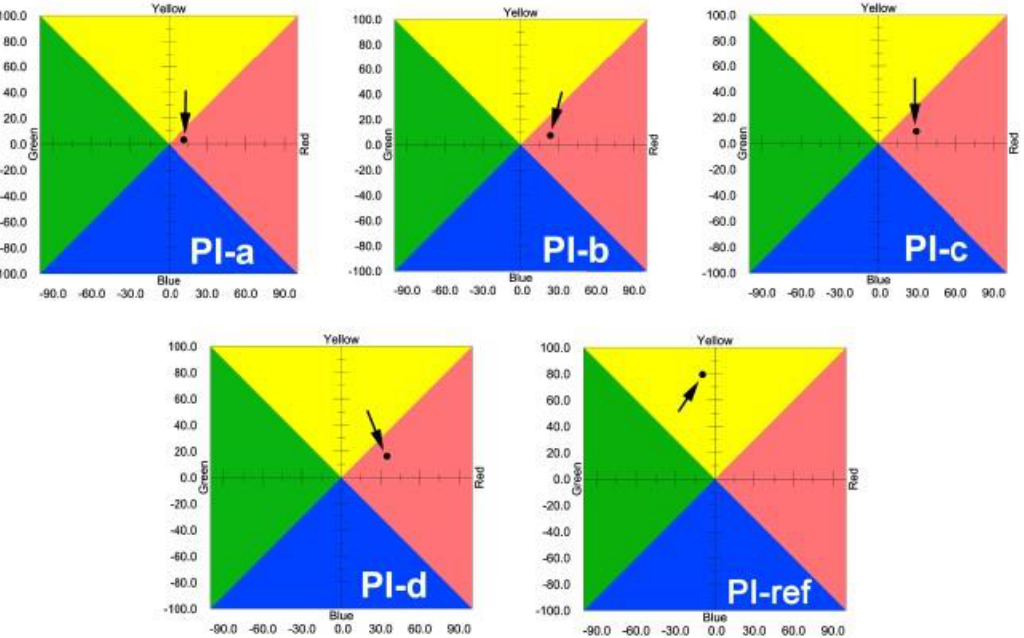
Polymers 2020 , 12 , x Figure 7. Commission International Eclairage (CIE) Lab color parameters of PI films.